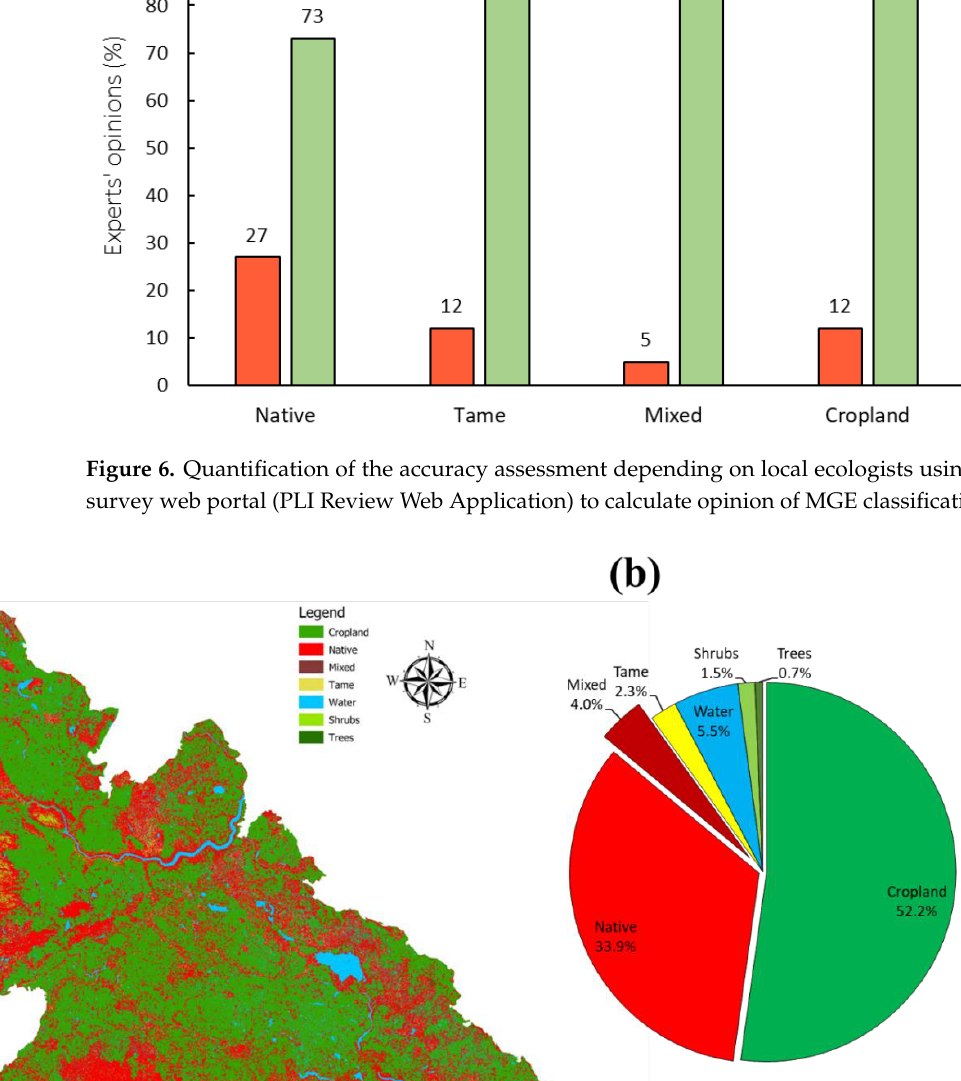
Figure 7. The MGE classification of 2019; ( a ) The spatial distribution of the MGE grasslands classification; ( b ) the percent- ages (%) of classes areas in the MGE of Saskatchewan. (%) of classes areas in the MGE of